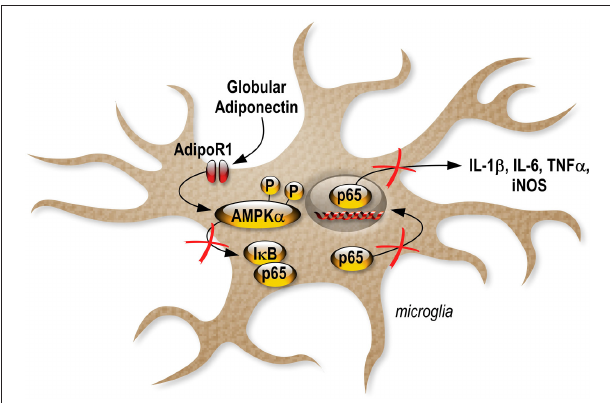
FIGURE 9 | Schematic illustration revealing the anti-inflammatory effects of gApN on microglia.